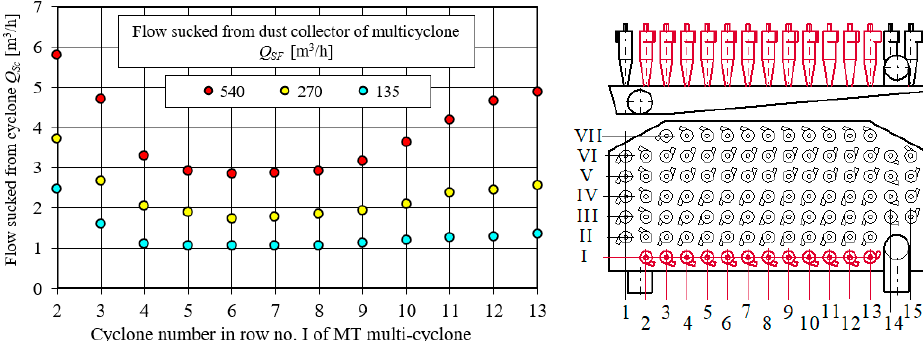
Figure 24. The values of the sucked flows Q Sc from the individual cyclones of the first (I) row of the MT multicyclone.